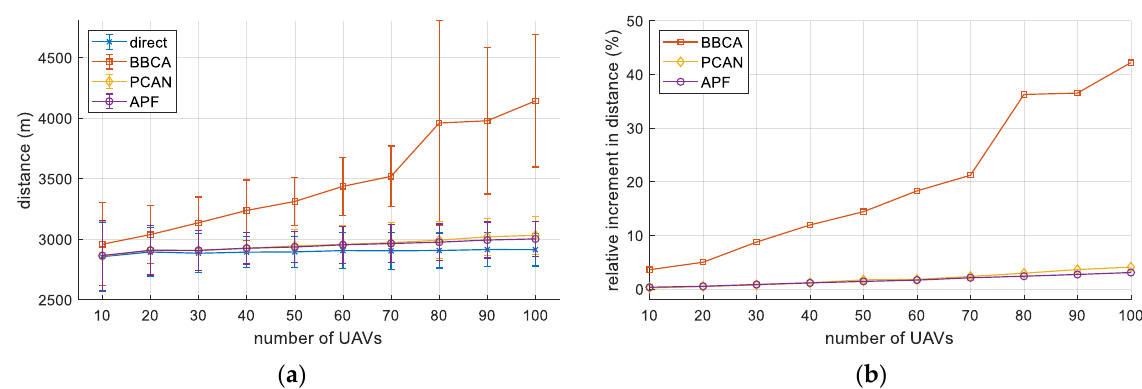
Figure 12. Multi-UAV study. Distance traveled: ( a ) absolute values (mean and standard deviation); ( b ) relative increase with respect to the direct algorithm.